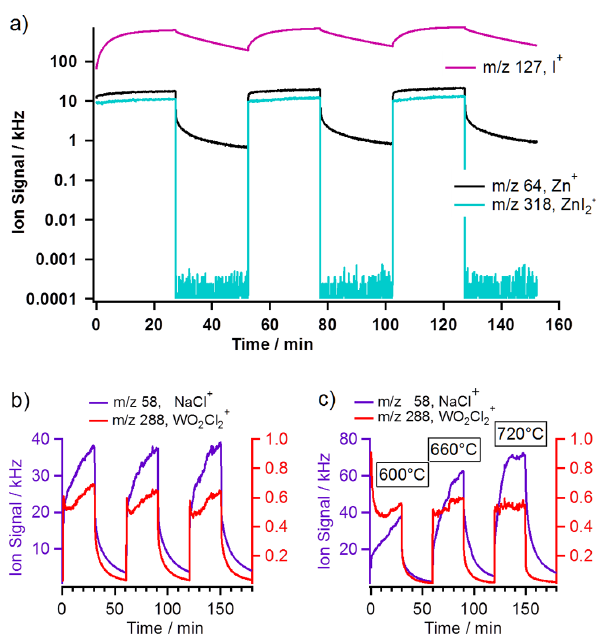
Figure 4. Time-resolved ion signal intensities from measurements of ZnI 2 (a) and NaCl (b, c) . In (b, c) the left axis is for NaCl + , and the right axis is for WO 2 Cl + . The measurements in (a) and (b) 2 were performed at a constant vaporizer temperature of 600 ◦ C; the measurements in (c) were performed at vaporizer temperatures of 600, 660, and 720 ◦ C. Precision of the measurements is